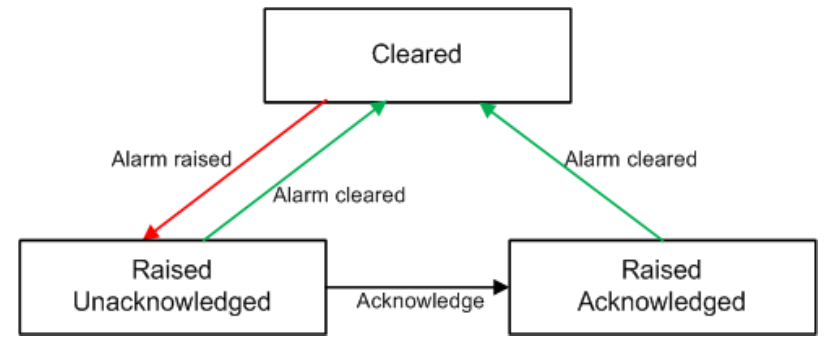
Figure 2. State diagram of an alarm.